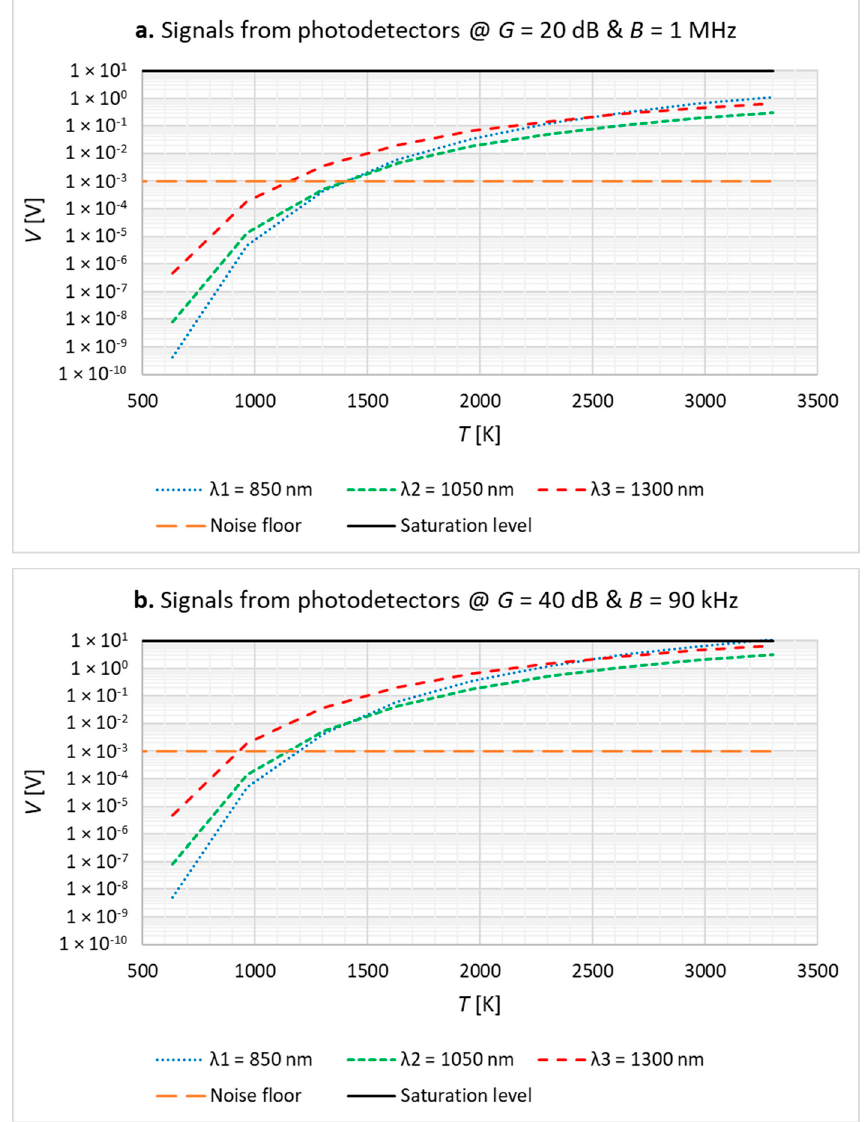
Figure 5. Modelled signals from photodetectors versus blackbody temperature at different G and B settings: ( a ) G = 20 dB and B = 1 MHz, ( b ) G = 40 dB and B = 90 kHz.